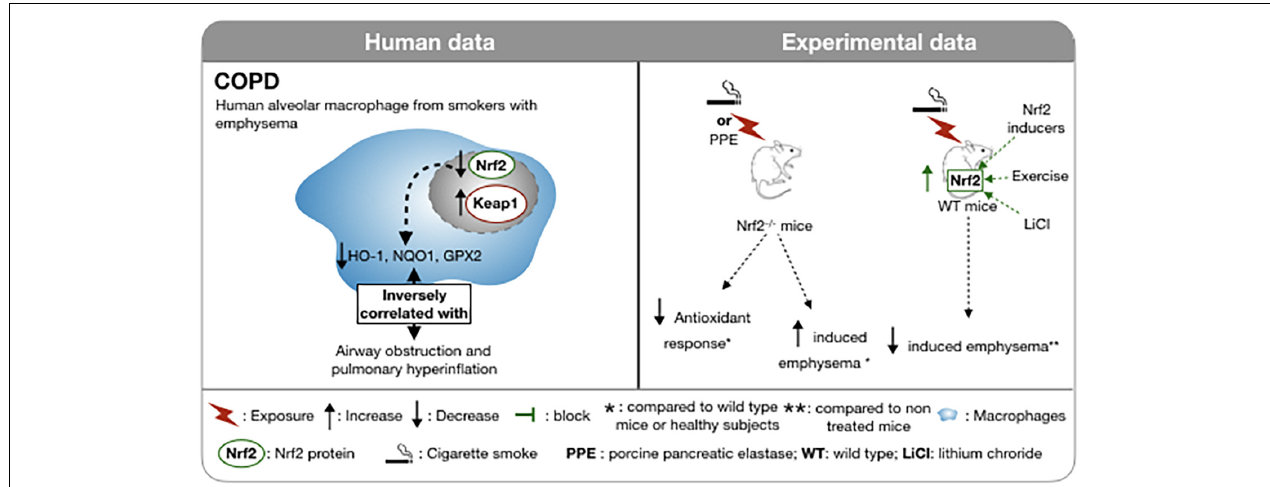
FIGURE 2 | Involvement of Nrf2 in COPD in human and in experimental models. In smokers with emphysema, the nuclear localization of Nrf2 is decreased in macrophages as well as the anti-oxidant response. This altered antioxidant response is inversely correlated with airflow obstruction. In Nrf2 deficient mice, CSE or pancreatic elastase intra-tracheal instillations evoke a decreased antioxidant response and an increase emphysema. In Nrf2-deficient mice, CSE or intra-tracheal instillation of pancreatic elastase results in a decreased antioxidant response and increased emphysema compared to wild type mice. Upregulation of Nrf2 by physical activity, LiCl or Nrf2 inducers reduces the induction of cigarette smoke-induced emphysema. ↑ , Increase; ↓ , Decrease; , block; *, compared to wild type mice or healthy subject; **, compared to non treated mice; , macrophages; , Cigarette smoke; WT, wild type; PPE, porcine pancreatic elastase; WT, wild type; LiCl, lithium